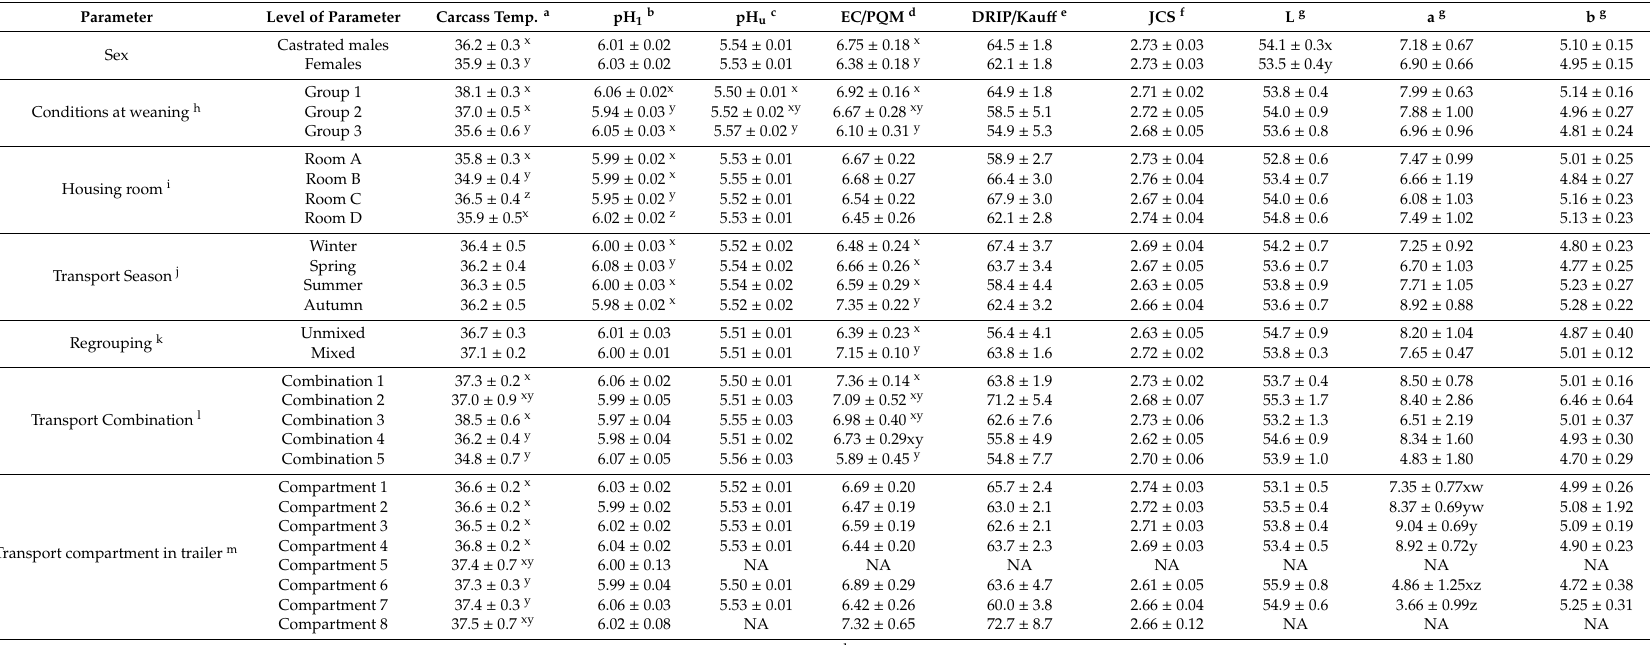
Table 5. Ls Means and standard errors of the e ff ect of background information of the pigs, period of starting fattening, compartment of housing, mixing and transport combination on meat